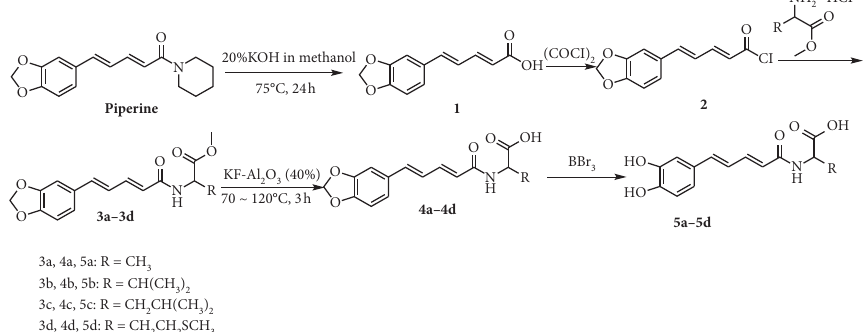
Figure 1: Scheme for the preparation of piperine derivatives. KOH:potassium hydroxide;(COCl)2:oxalyl chloride;KF: potassium fluoride: Al 2 O 3 :aluminium oxide; BBr3:boron